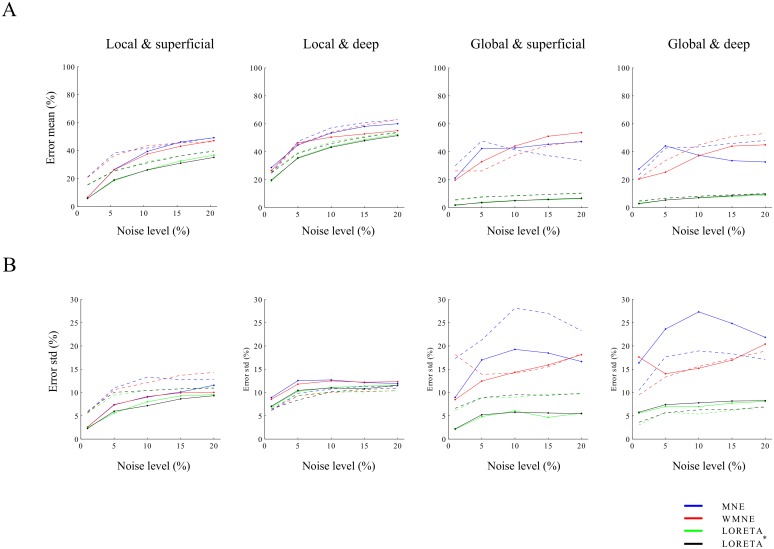
Performance of the imaging methods.A. Mean reconstruction errors for the four inverse methods (MNE (blue), WMNE (red), LORETA (green), and LORETA* (black)) as a function of noise-level and for each of the four combinations of simulated currents (superficial/deep and local/global). Noise-levels are 1, 5, 10, 15, and 20%. The mean errors were obtained by averaging over 500 realizations. B. Same format as in A. but displaying the error standard deviations instead of their means. In A and B, the solid lines correspond to the case of no mismatch in the a priori inter-laminar current profiles. The dashed lines correspond to the case of a mismatch in the a priori inter-laminar current profiles (see text).